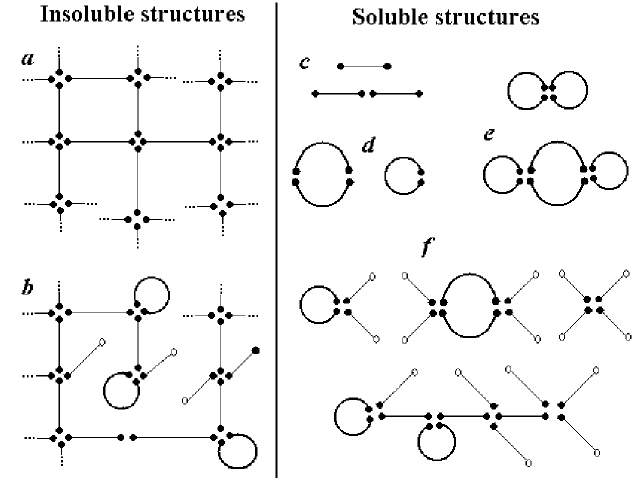
Fig. 1 Some of the possible structures of the associates: a { the ideal network, b { a real network with defects, c { the acyclic bifunctional free molecules and their dimeric associates, d { the cyclic dimeric associates of the bifunctional molecules, e { the tetramerous cyclic associates of the bifunctional molecules, f { combined tetramerous associates of the bi- and monofunctional molecules. The solid circles designate the /living/ chain-ends, the open ones, the non-functional